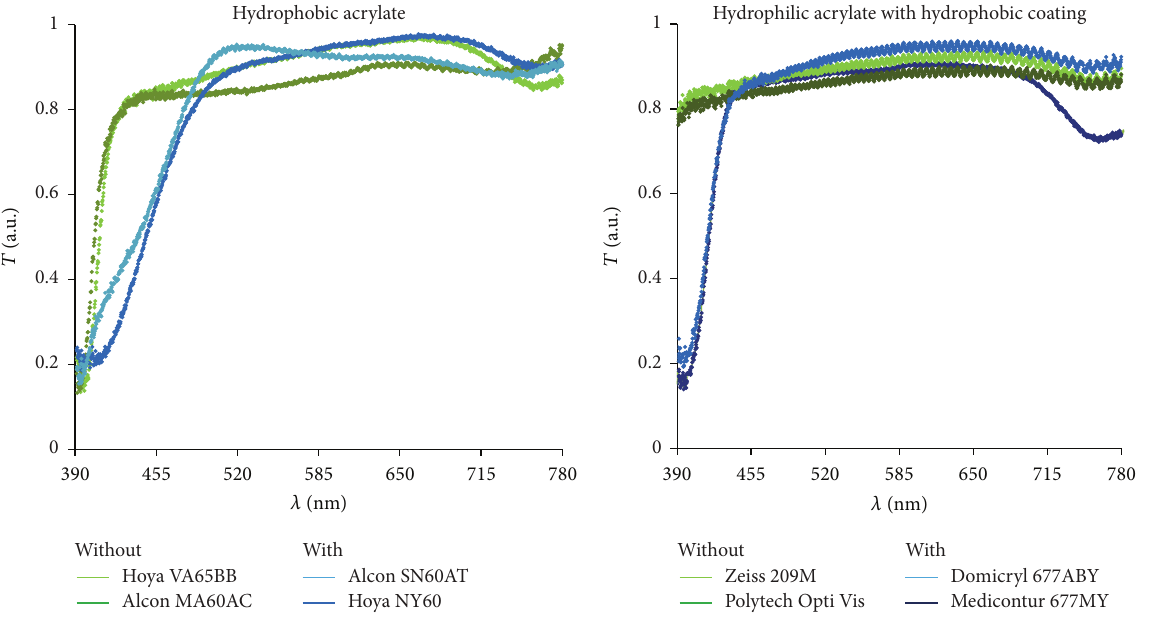
tested show the expected difference between materials with and without blue-light filter. Both material groups bic coating) show lower transmittance in the range from 390 nm to 450 nm when the IOLs have a blue-light filter: similar findings have already been published elsewhere